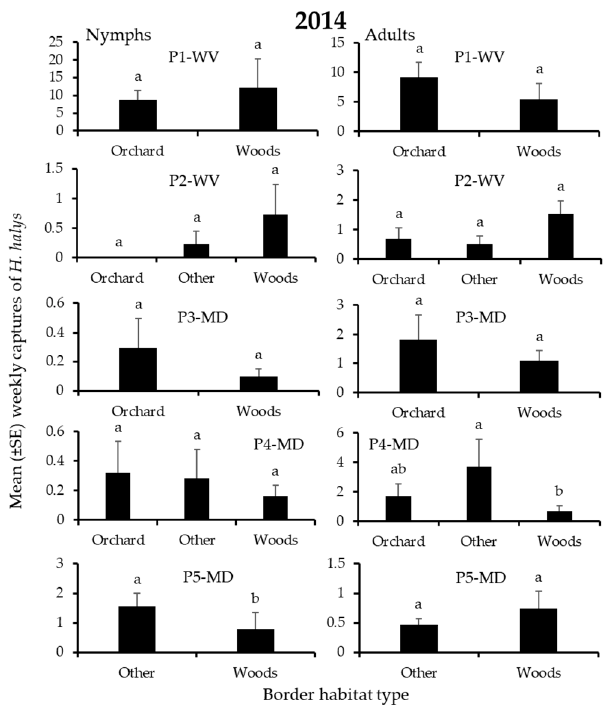
Figure 8. Mean ( ± SE) weekly trap captures of H. halys nymphs (left) and adults (right) in pheromone-baited traps on the perimeter of 5 peach orchard blocks in the Mid-Atlantic, USA, from 7 April to 9 October 2014. Bars with shared letters are not significantly different (Tukey HSD, α = 0.05).